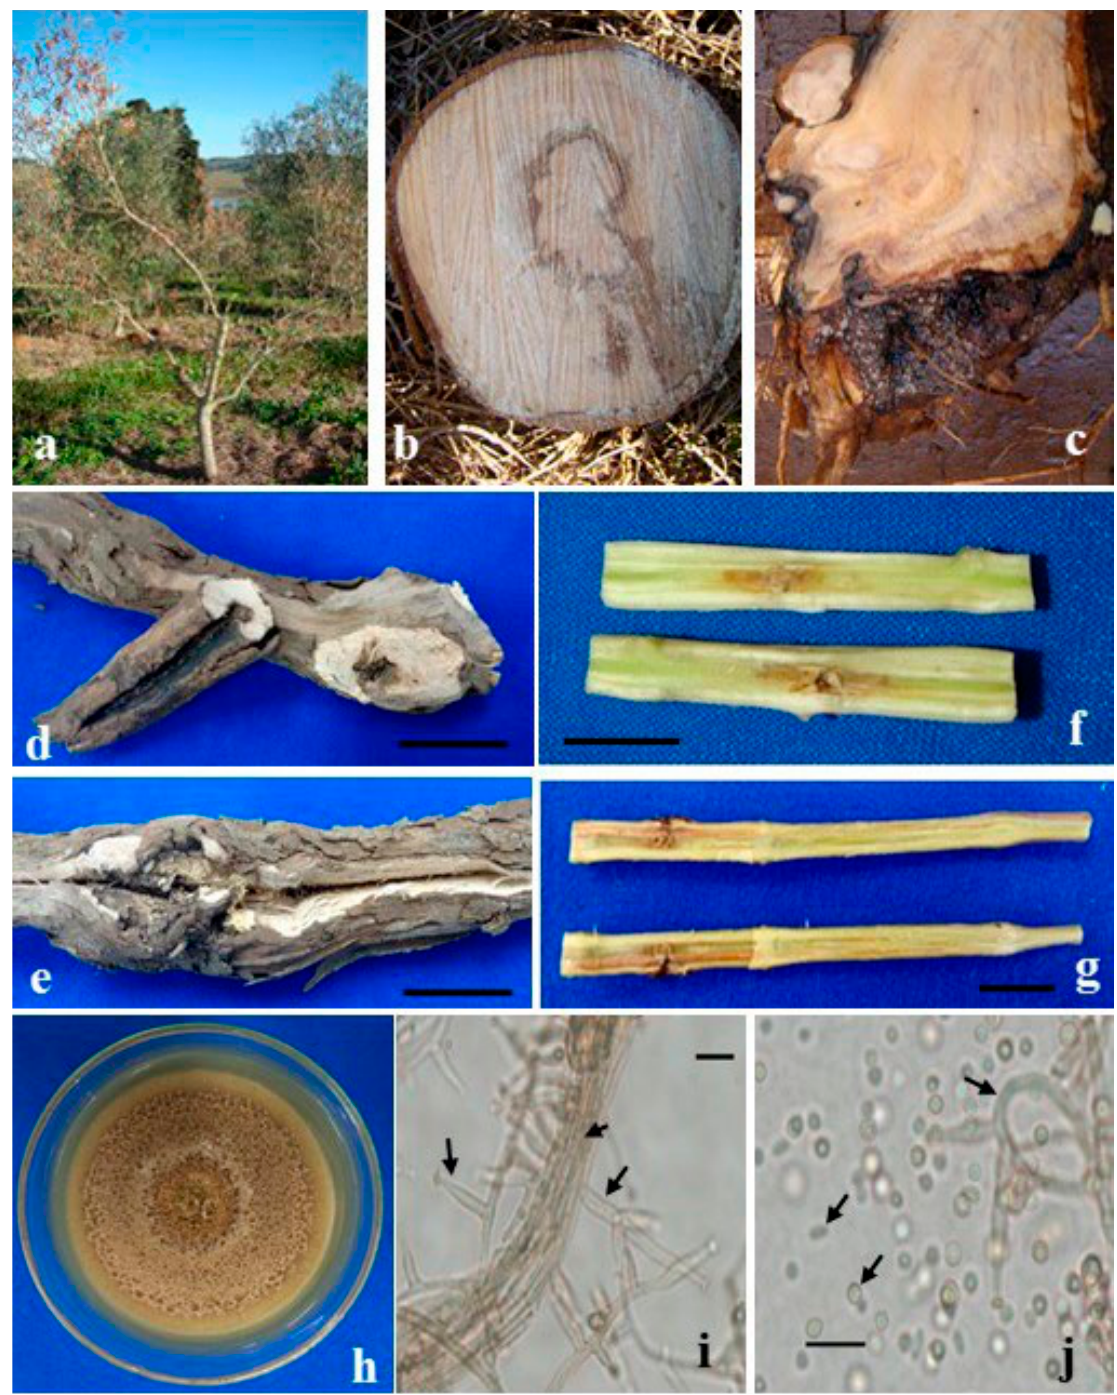
Figure 1. (a–c) Disease symptoms in olive trees. (a) Severe dieback of twigs and branches, with browning of leaves, and premature plant death. (b) Transversal cross section of an affected trunk showing dark brown to black streaking in the crown. (c) Dark streaking in the core of wood and necrotic lesions affecting the bark. (d–e) Grapevine branches showing cracks and vascular discoloration. Scale bar = 1 cm. (f–g) Longitudinal sections showing acropetal and basipetal wood discolouration from inoculation points in (e) olive tree and (f) grapevine. Scale bar = 1 cm. (h) Pleurostomophora richardsiae colony, on MEA after 21 d in the dark at 25°C. (i–j) Micrographs of P. richardsiae struc- tures. Scale bar = 10 µm. Arrows in (i) show a phialide, a conidiophore and hyphal bundles. Arrows in (j) indicate subglobose and oblong ellipsoid conidia, and coiled